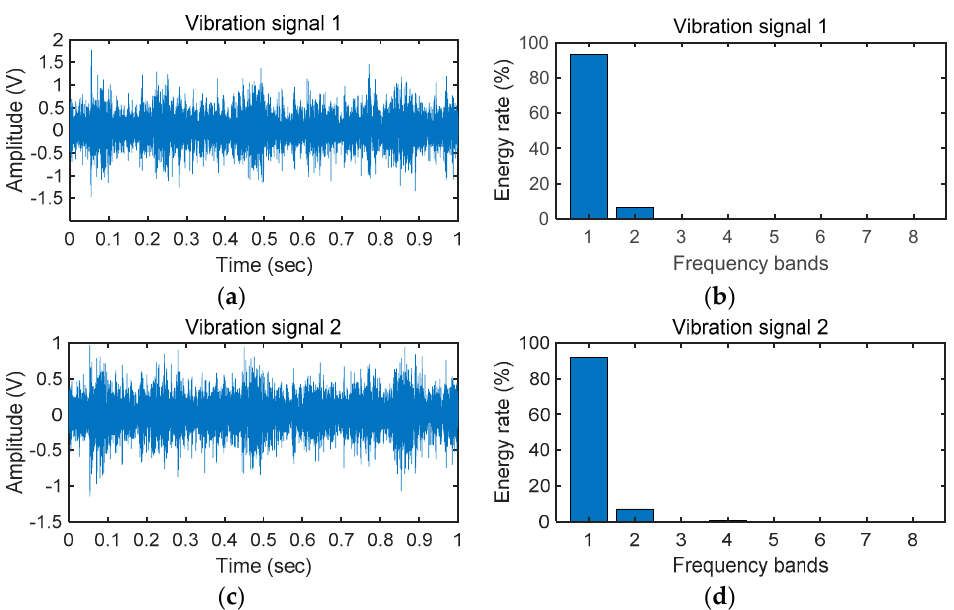
Figure 7. The raw vibration signals and energy distribution map.